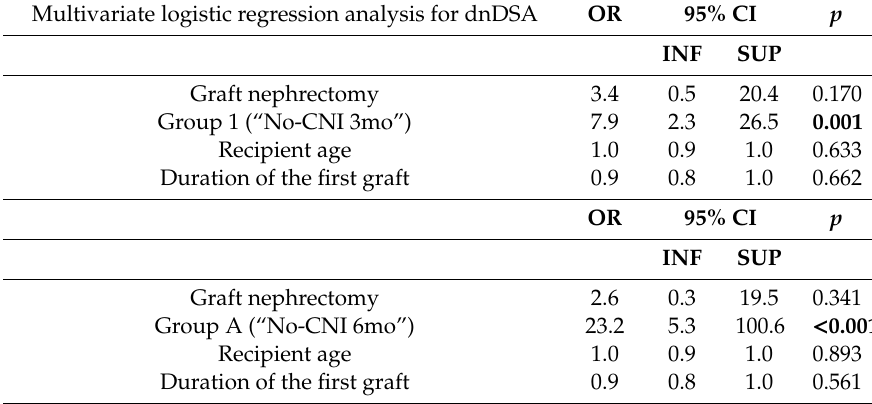
Table 8. Results of the multivariate logistic regression analysis for dnDSA. The bold: p values less than 0.05 defined statistical